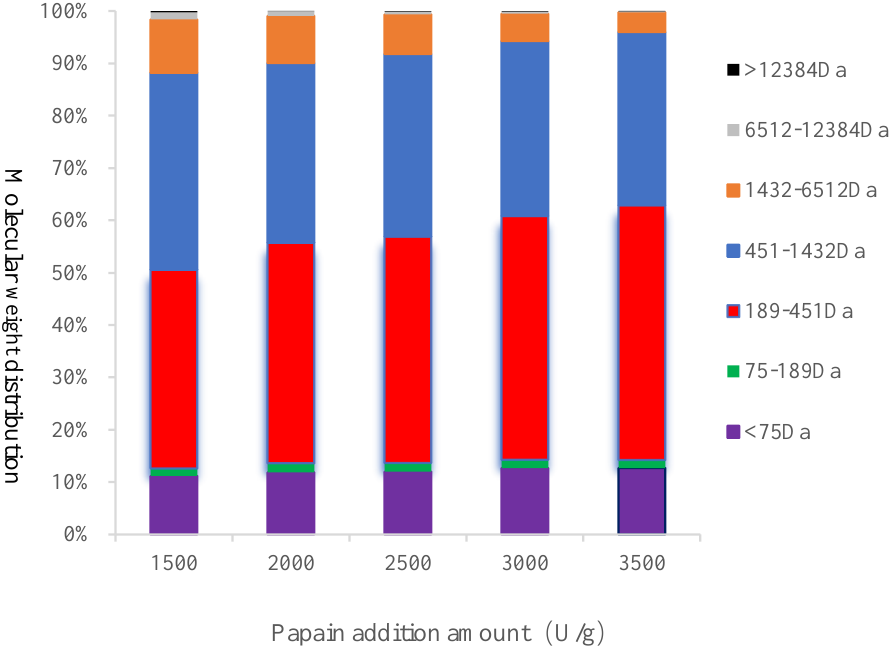
Figure 7. Molecular weight distribution of papain hydrolysate for different enzyme additions. Meanwhile, for each protease hydrolysate, the degree of hydrolysis was significant difference as assessed using the OPA method (Figure 8). The degree of hydrolysis of mild and extensively hydrolysate proteins were <10% and >20%, respectively. The degree of hydrolysis of pepsin in acid protease, considered as mild hydrolysis, was the lowest. Alcalase exhibited a low degree of hydrolysis and hydrolyzed only slightly with the enzyme amount <3500 u. The hydrolysis degree of papain was 10–15% for 1500–3500 u of enzymes. Protease M performed extensively hydrolysis, while Neutrase was stable with about 10% hydrolysis in the 1500–3500 u range. The hydrolysis degree of Protamex was 13% at 3500